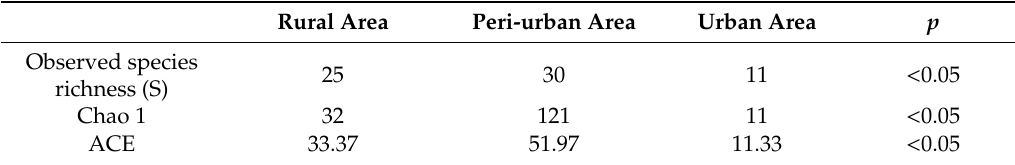
Table 2. Mosquito richness across habitats in Dschang, West-Cameroon.